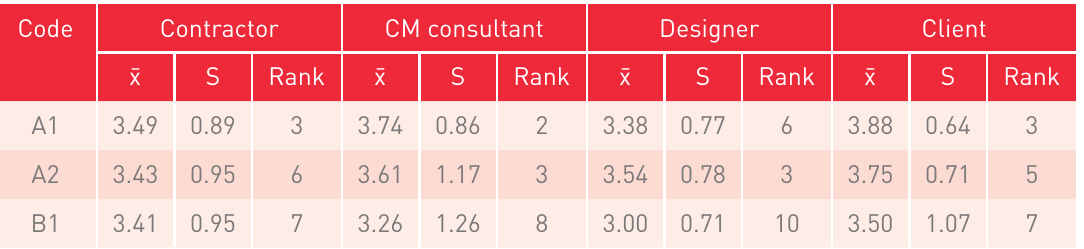
Level of interest among construction